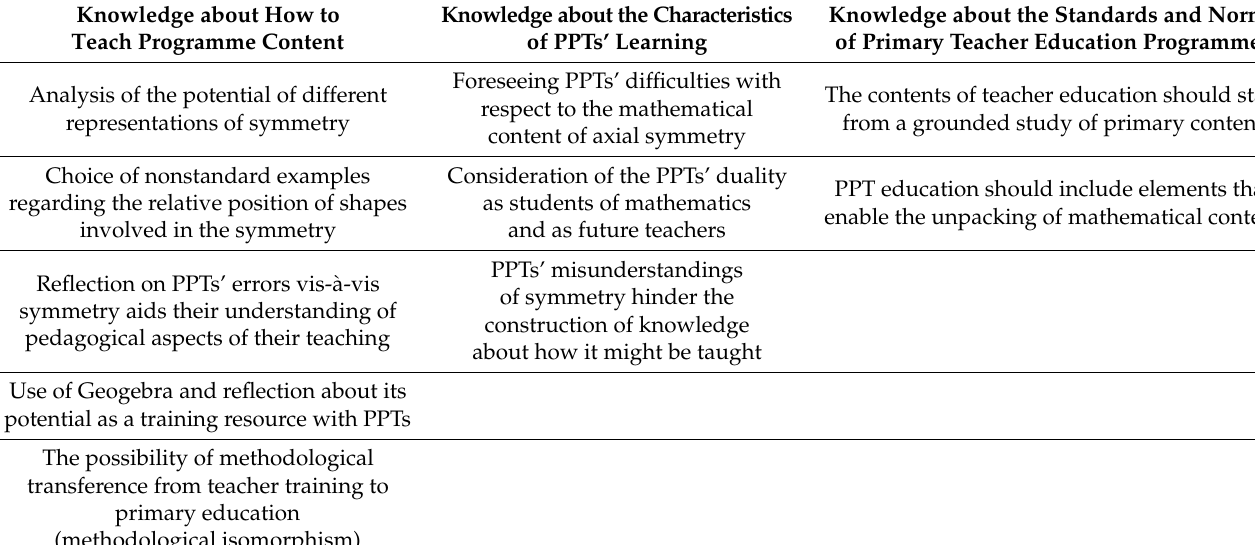
Table 1. Indicators of the educator’s pedagogical